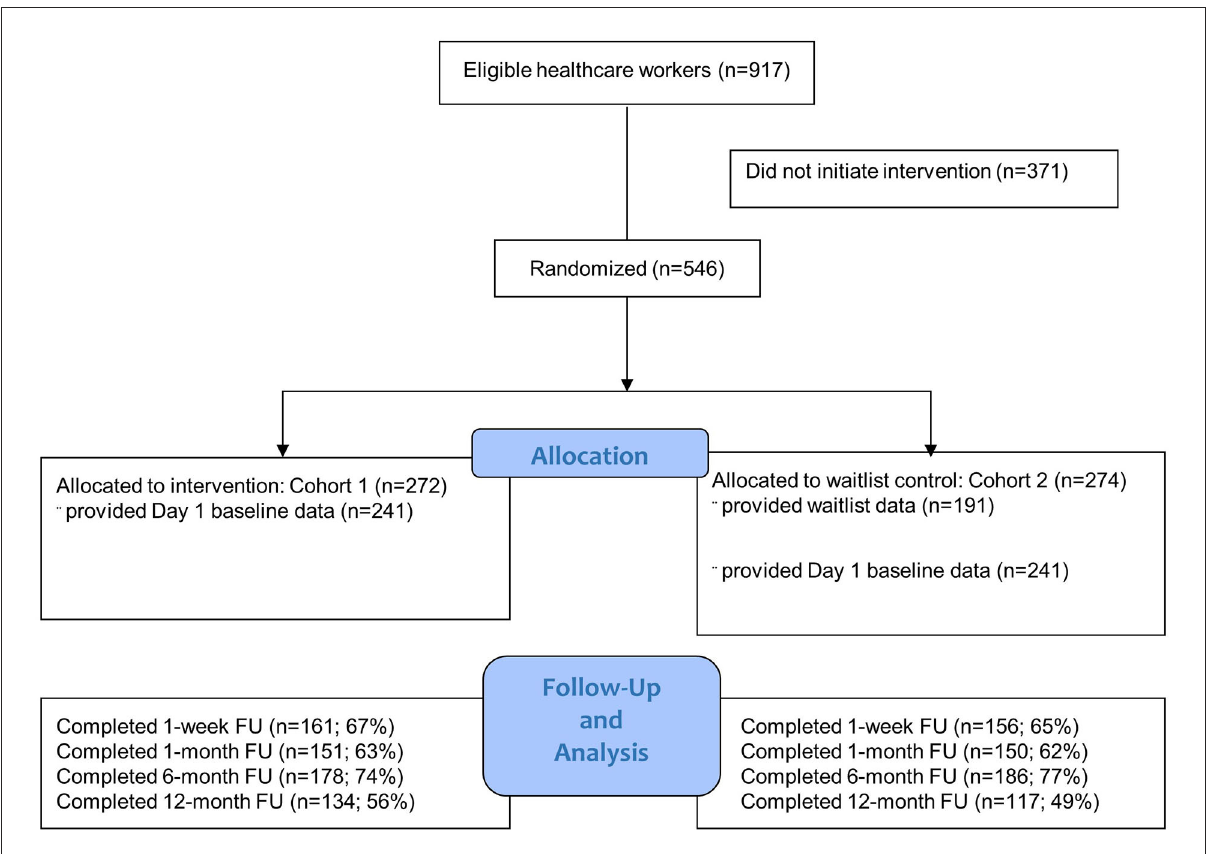
FIGURE1 CONSORT